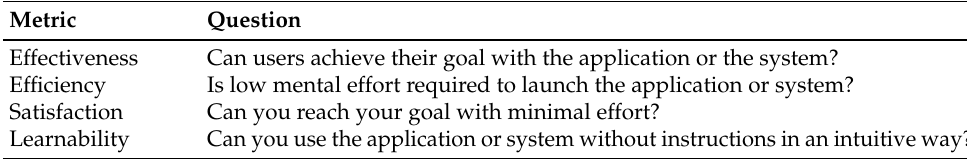
Table 6. Basic usability and user experience